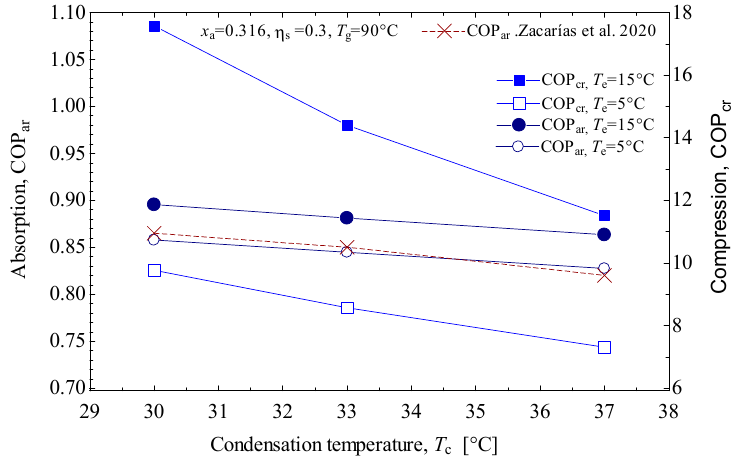
Figure 2. Hybrid chiller coefficient of performance (COP) and COP ar validation as a function of T c .